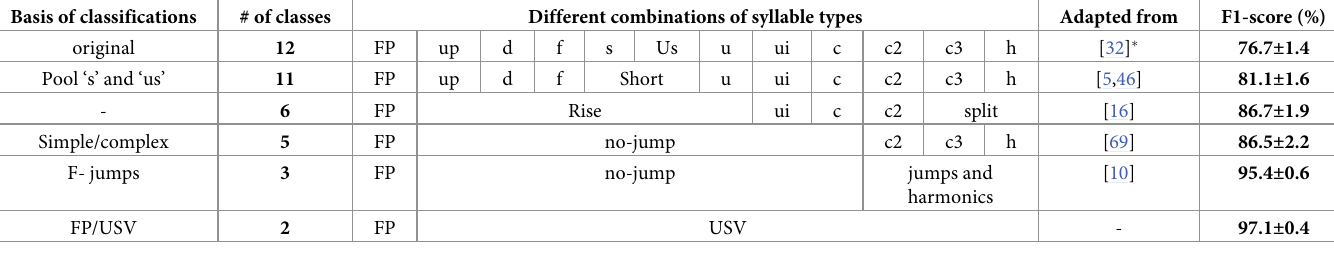
Table 2. BootSnap performance in classifying the DEV_test dataset in various combinations of classes. Basis of